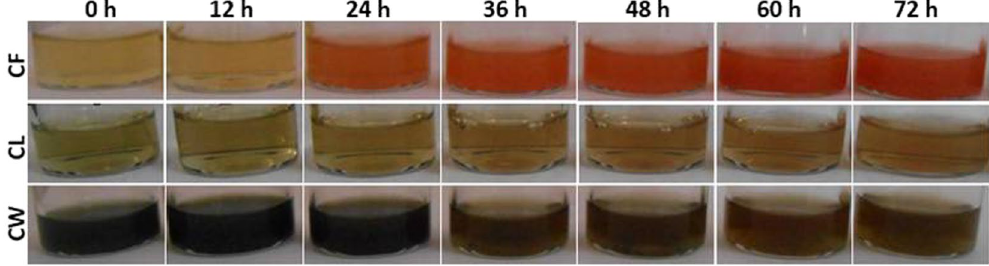
Figure 1. Trichogenesis of selenium nanoparticles (SeNPs) from the T . asperellum at different time intervals (hours). CW: Crude cell wall; CL: Cell lysate; CF: Culture